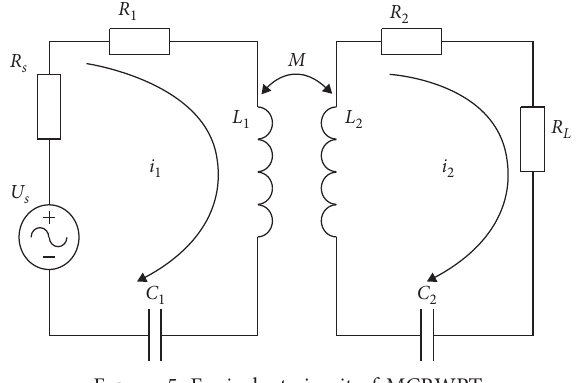
Figure 5: Equivalent circuit of